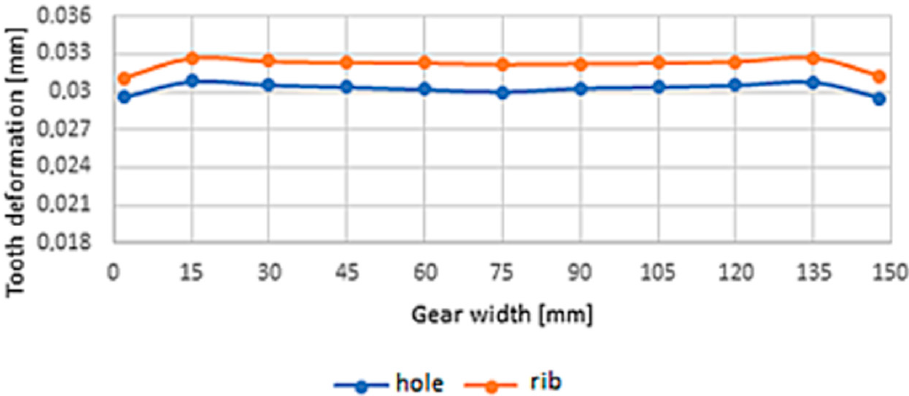
Figure 11. Deformation along the width of the tooth for model B1.